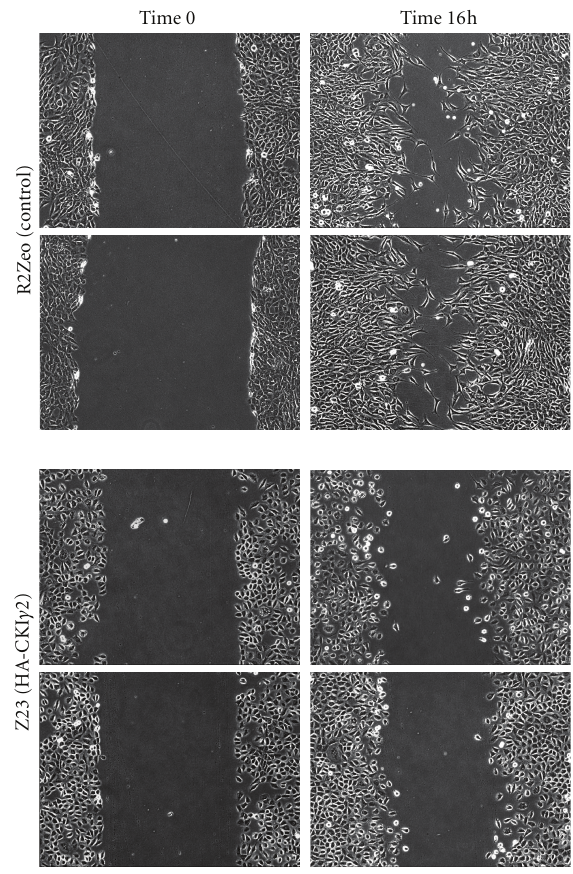
Figure 2: CKI γ 2 overexpression in fibroblasts impairs cell motility. Migration of serum starved control (R2Zeo) and HA-CKI γ 2 overexpressing fibroblasts (Z23) were evaluated in wound healing assays. Pictures (10X) from the same area were taken at time 0 and 16 hours after the